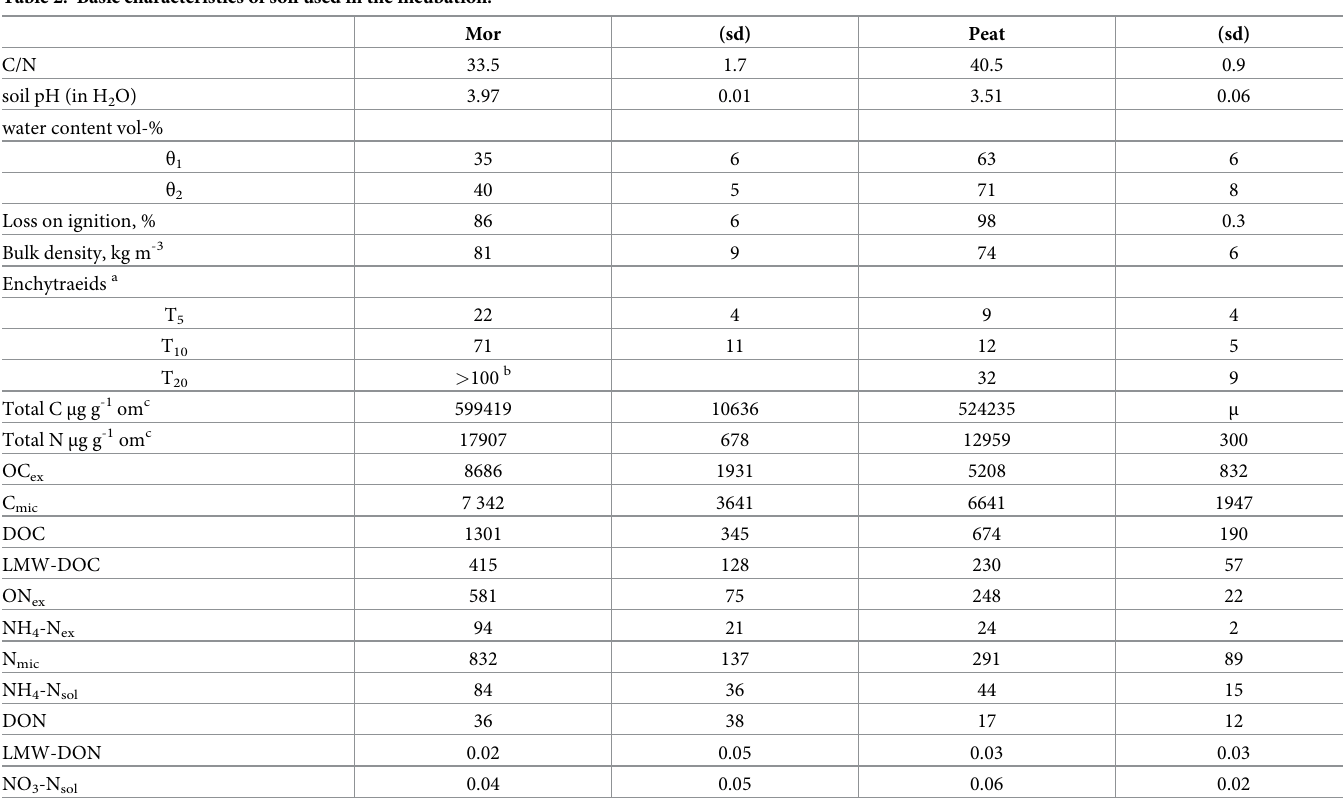
Table 2. Basic characteristics of soil used in the